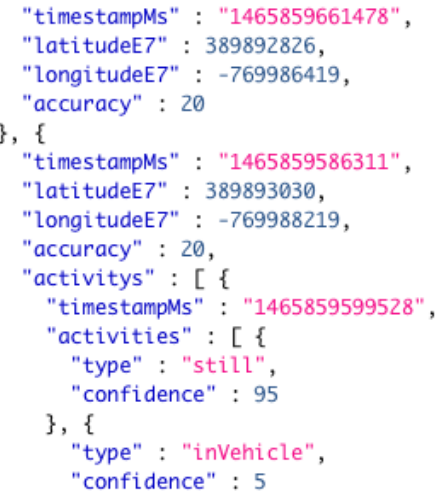
Figure 3. Example of raw data in original JavaScript object notation (JSON) format.